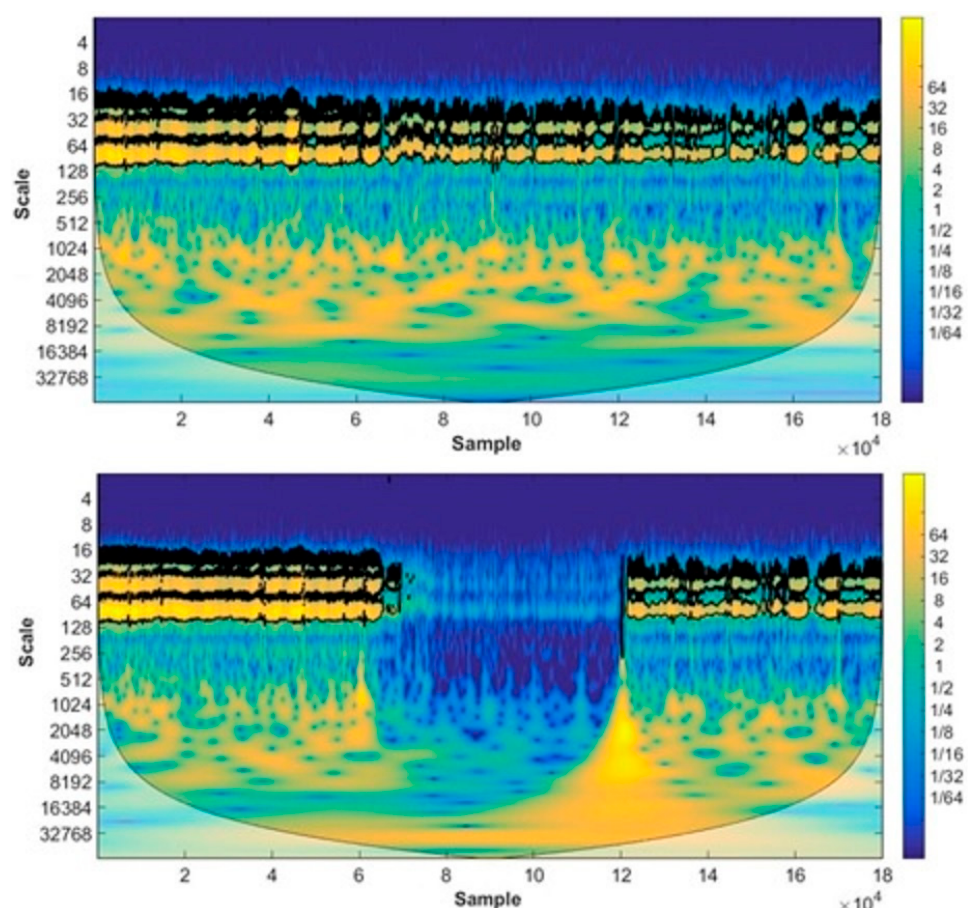
Figure 1. WT scalogram of the PPG signal from the control (top) and test (bottom) feet from a representative subject (20 y.o.).